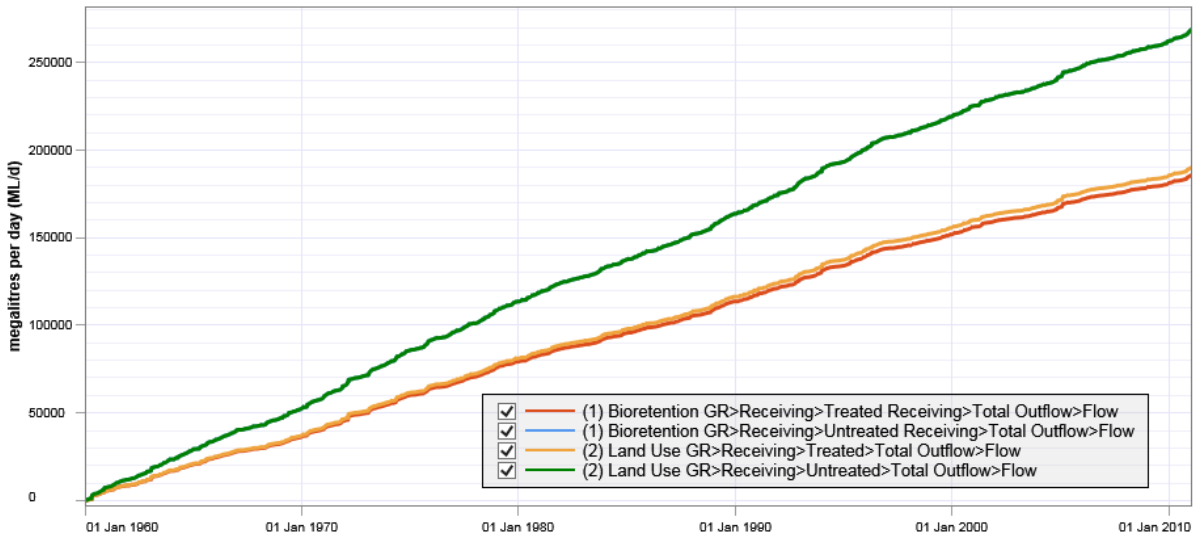
Figure 11. Cumulative runoff volume from the land use node and bioretention node approaches .